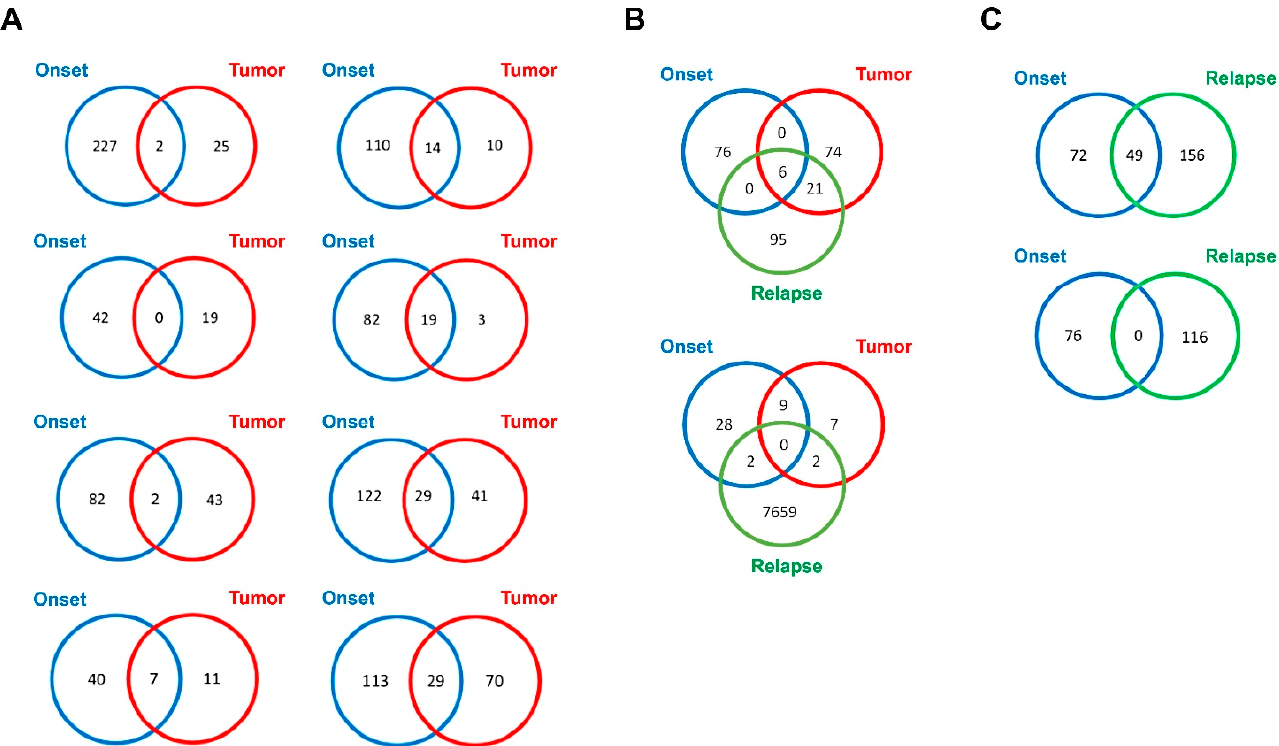
Figure 3. Venn diagrams of somatic single nucleotide variants (SNVs) shared by exo-DNA and tumor DNA. ( A ) SNVs in common between exo-DNA at onset and the corresponding tumor DNA. ( B ) SNVs in common among exo-DNA at onset, exo-DNA at relapse, and the corresponding tumor DNA. ( C ) SNVs in common between exo-DNA at onset and exo-DNA at relapse.